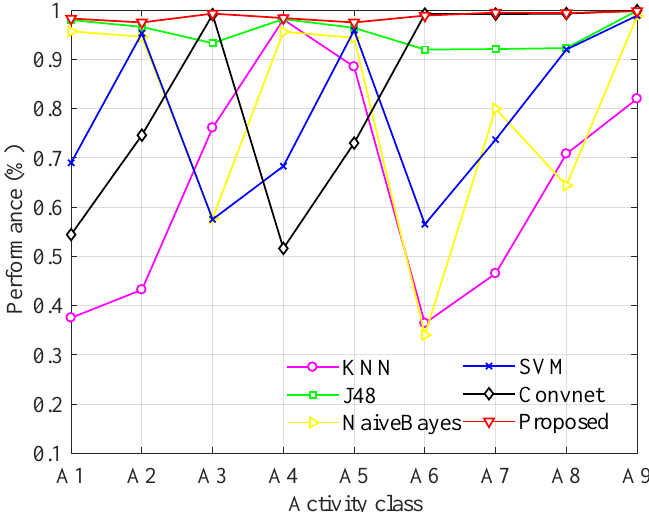
Figure 10. Performance comparison in each type of activity with other methods.